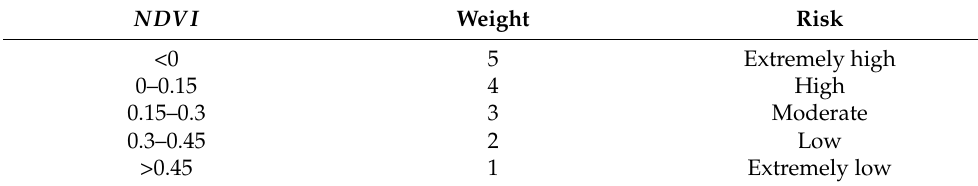
Figure 8. The base map of NDVI in Laoshan. Each level is determined by the fire risk classification. Table 7. Fire risk classification of NDVI